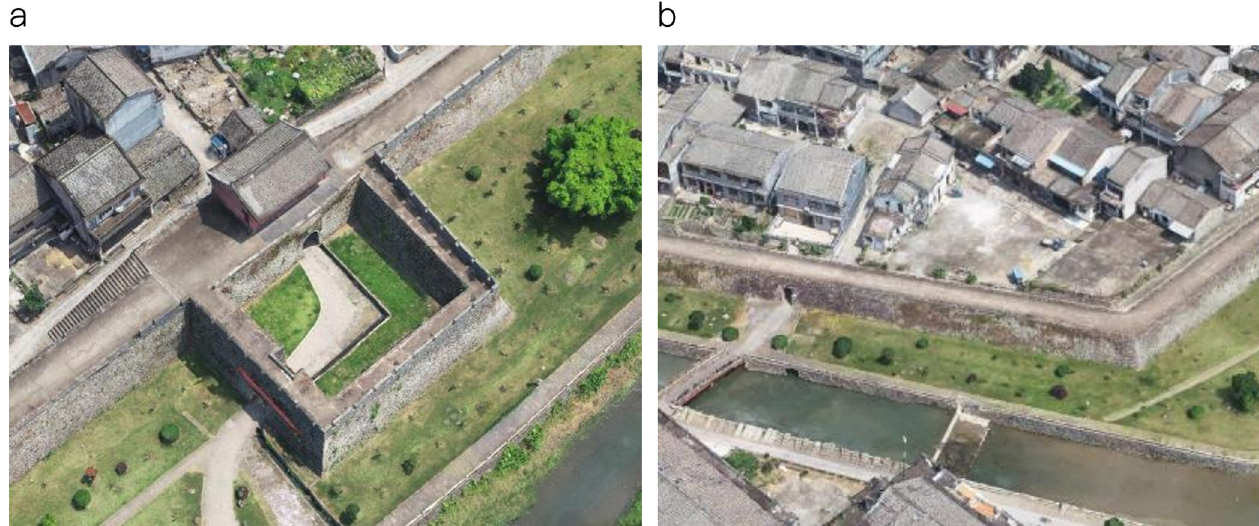
Fig 3. The barbican of Pu Zhuang Suo-Fort point cloud model (a) and the wall of Pu Zhuang Suo-Fort point cloud model (b).